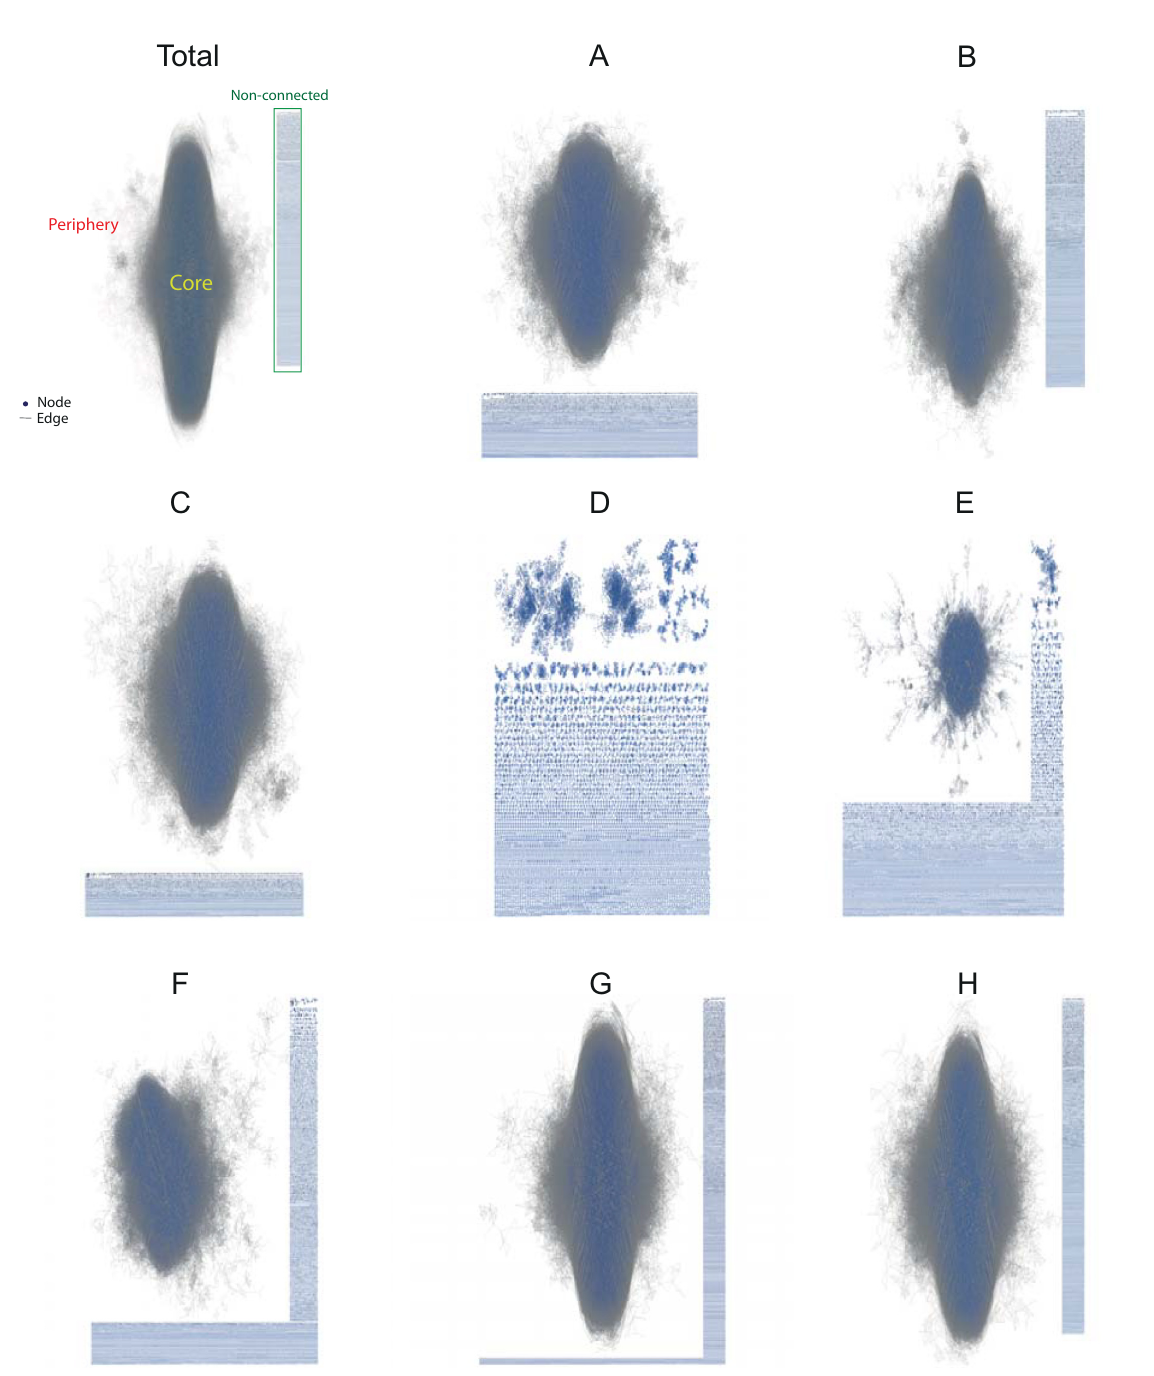
Fig 1. Visualization of the technology co-inventor networks using Cytoscape, 1999–2019.